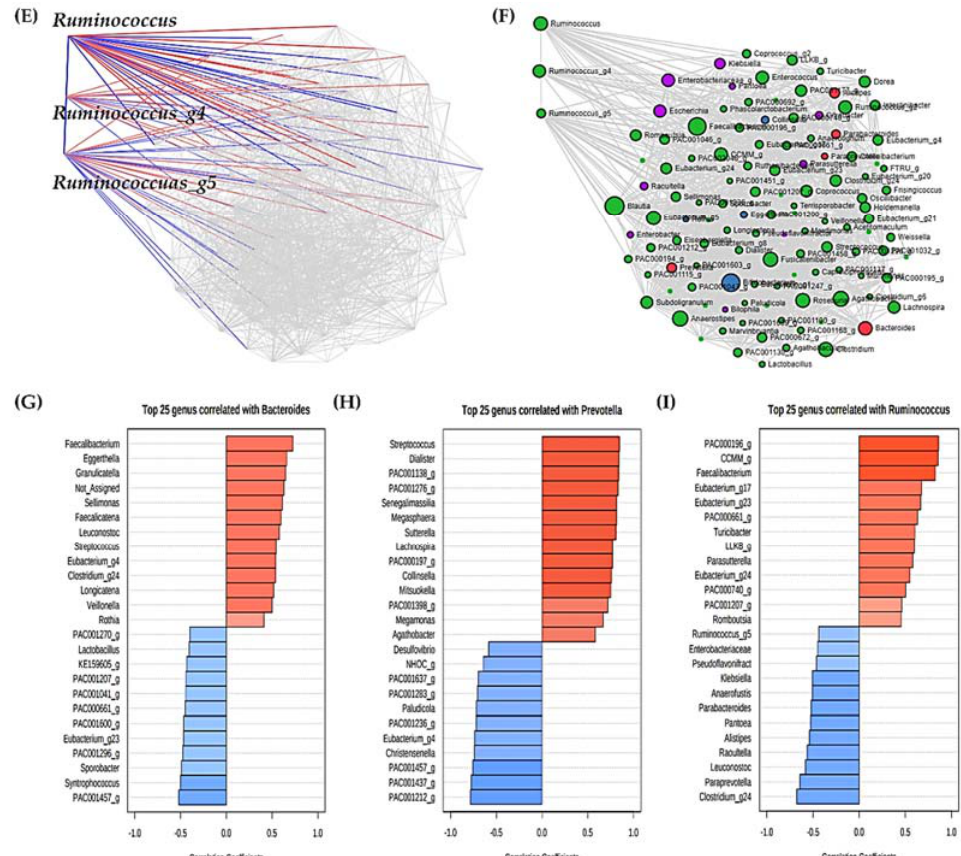
Figure 7. Correlation analysis between main strains of each enterotype and other strains. ( A ) SparCC between Bacteroides and other strains. ( B ) Line between bacteria with significant correlation with Bacteroides . ( C ) SparCC between Prevotella and other strains. ( D ) Line between bacteria with significant correlation with Prevotella . ( E ) SparCC between Ruminococcus (and Ruminococcus_g4 , Ruminococ- cus_g5 ) and other strains. ( F ) Line between bacteria with significant correlation with Ruminococcus (and Ruminococcus_g4 , Ruminococcus_g5 ). Algorithm performed SparCC, which assumed sparse networks and performed iterations using log-ratio transformation and identified taxa with high correlation. Permutation (SparCC) performed 100. Taxonomy level was Genus level, and p -value threshold was performed as 0.05. The experimental factor was Enterotype, the correlation threshold was set to 0.3, and the coloring options were set differently for each Phylum. ( G ) Overall pattern search between Bacteroides and other strains according to PYP intake. ( H ) Overall pattern search between Prevotella and other strains according to PYP intake. ( I ) Overall pattern search between Ruminococcus and other strains according to PYP intake. Taxonomy level was performed with Genus. Distance measure was performed by SparCC, and experimental factor was performed by